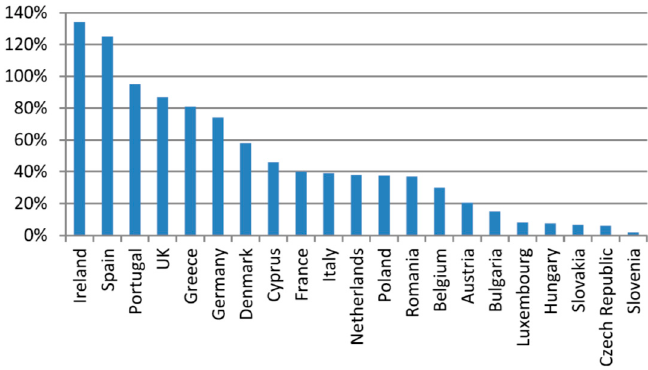
Figure 4. Wind capacity as proportion of minimum demand in summer 2020 (data from [7]).